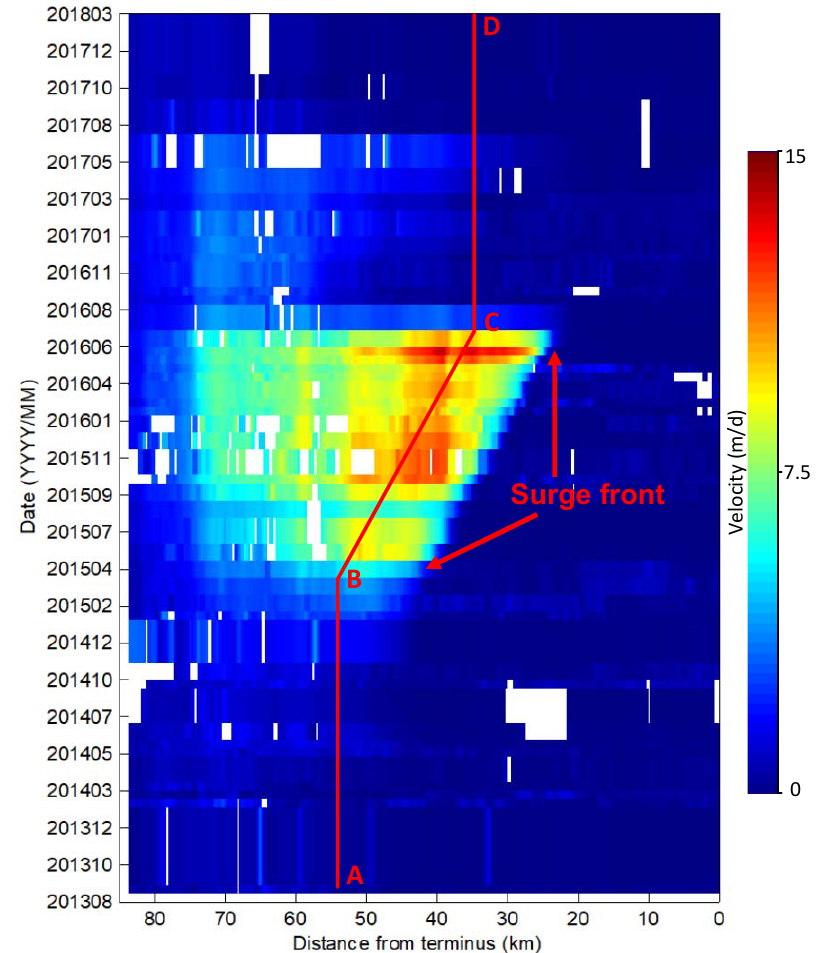
Figure 4. Spatial-temporal changes of surface velocities along the centerline, whose location is marked in Figure 1. The width of each profile indicates the interval of the image pair. The right edge is near the terminus and the left edge is upstream. The red line in the figure is a manually delineated line used to reveal the fluctuation of glacier velocity. A, B, C and D mark the locations of the inflection points along the line.